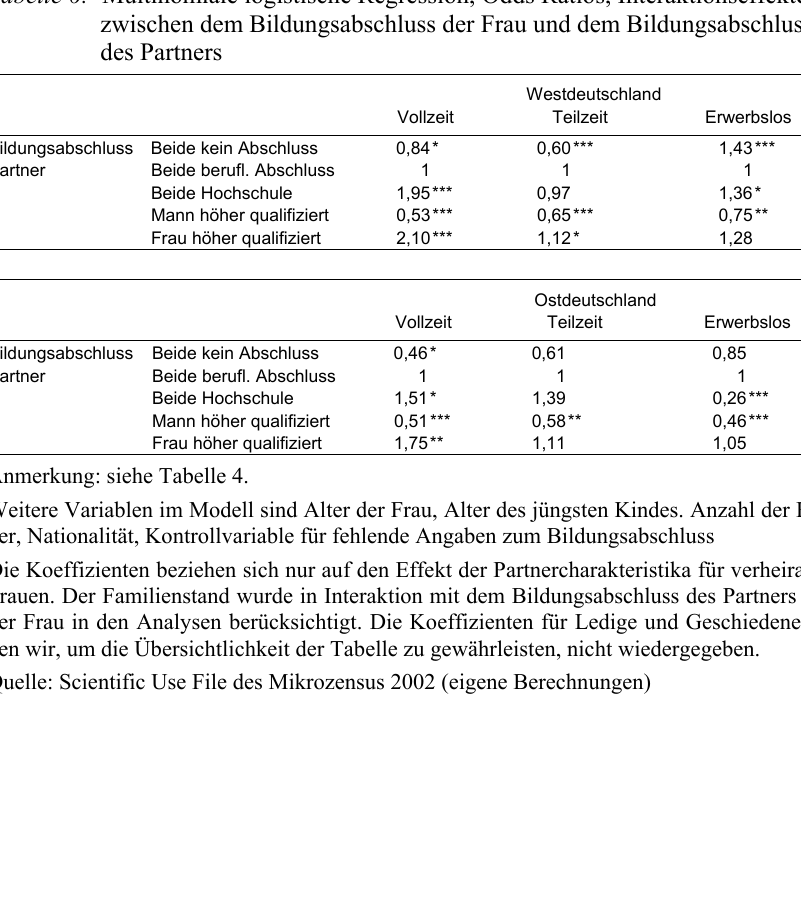
Tabelle 6: Multinomiale logistische Regression, Odds Ratios, Interaktionseffekte zwischen dem Bildungsabschluss der Frau und dem